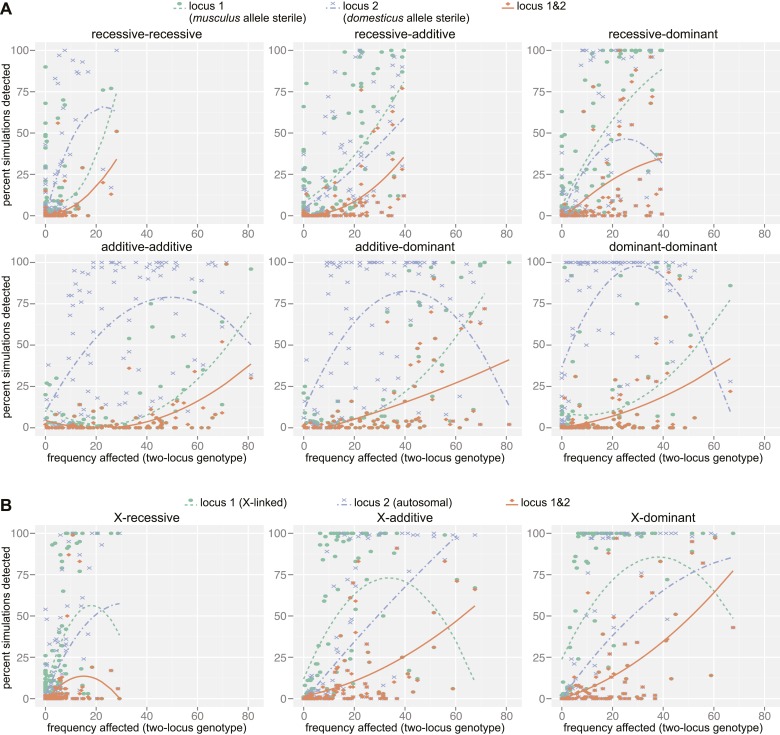
Mapping power in simulations.Each panel illustrates results from a single genetic architecture model for (A) 100 autosomal–autosomal SNP pairs and (B) 100 X—autosomal SNP pairs. Each point represents the percentage of data sets generated from a single SNP pair in which locus 1 (domesticus sterile allele; green), locus 2 (musculus sterile allele; purple), or both loci (orange) were identified by association mapping (≥1 SNP significant by permutation based threshold within 10 Mb of ‘causal’ SNP). The x axis indicates the percentage of individuals with partial or full sterility phenotypes. Curves were fit using second order polynomials. In (A), locus 1 indicates the SNPs with musculus alleles sterile and locus 2 indicates the SNPs with domesticus alleles sterile. In (B), locus 1 is the X-linked SNP and locus 2 is the autosomal SNP.DOI:
http://dx.doi.org/10.7554/eLife.02504.01610.7554/eLife.02504.017Figure 4—source data 1.Z scores for simulation models.